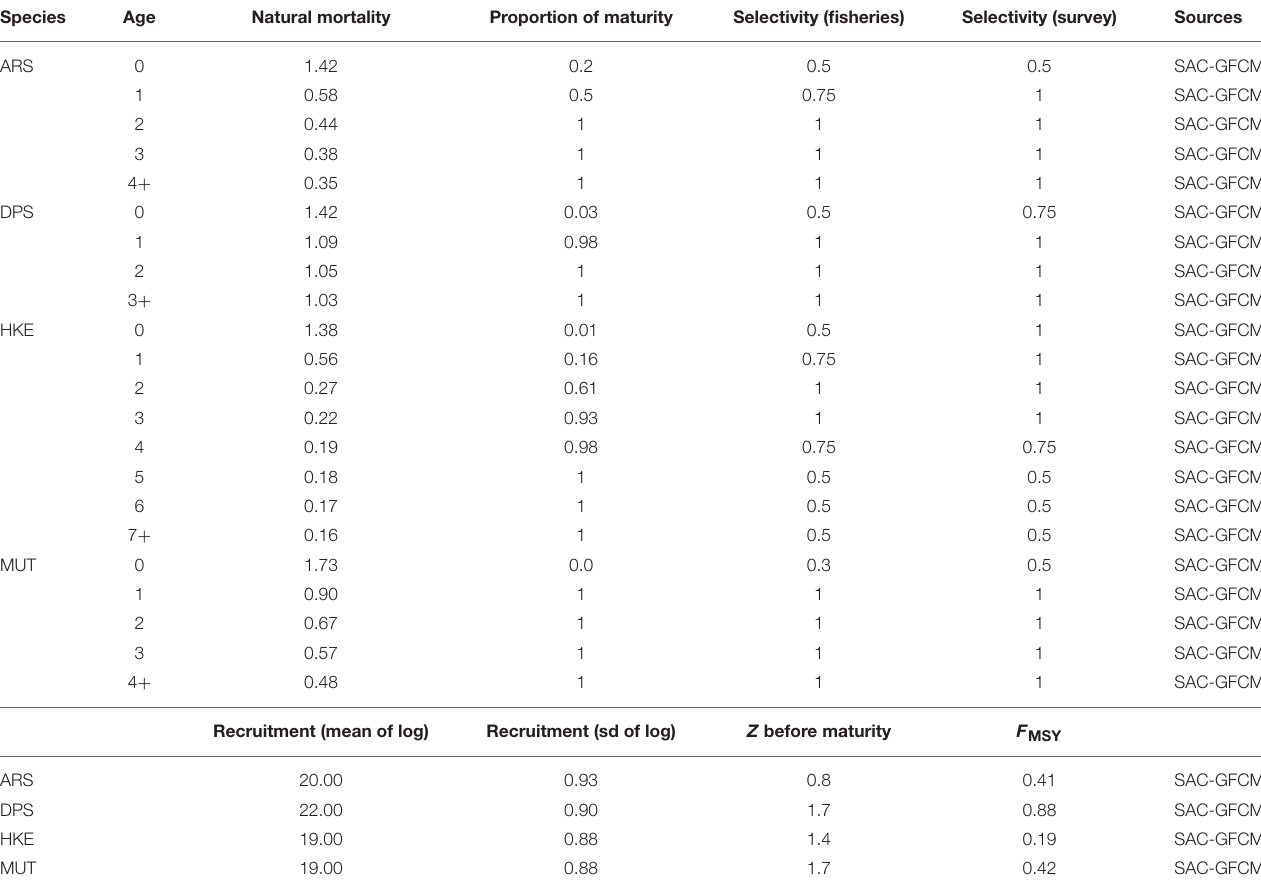
TABLE 2 | Biological parameters referred to age, used to set up MICE model. Species Age Natural mortality Proportion of maturity Selectivity (fisheries) Selectivity (survey)